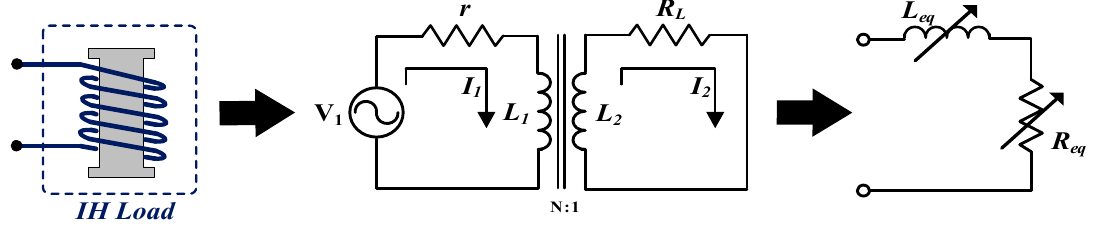
Figure 9. Equivalent circuit transformation of the induction heating (IH) system.